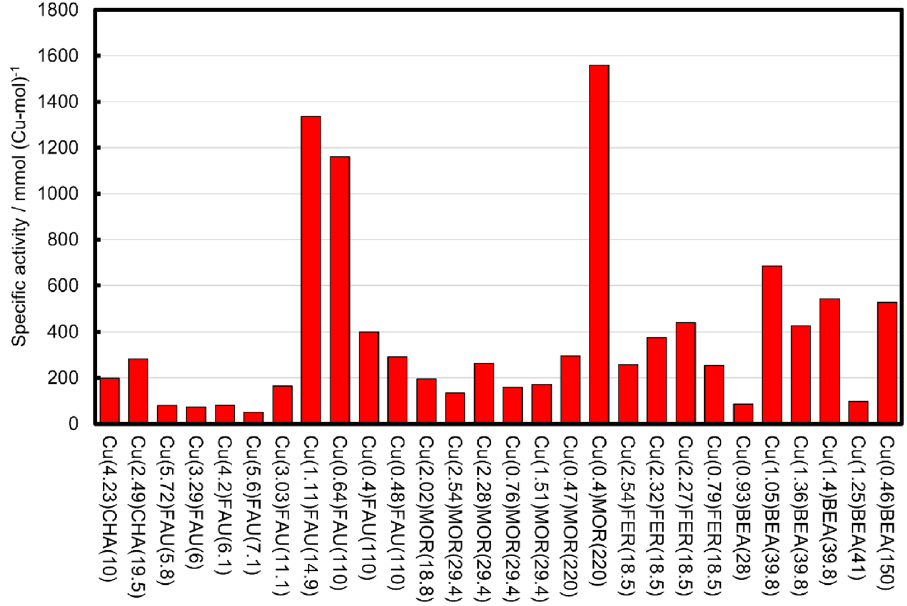
Figure 1. Specific activity of twenty-eight Cu zeolites for the CH 4 –H 2 O 2 reaction. Reaction conditions: CH 4 3.5 MPa, 30 wt% H 2 O 2 155 μL, H 2 O 3 mL, catalyst 10 mg, 60 °C, 1 h. The specific activity is determined by dividing the product increments shown in Fig. S2c with the amount of Cu listed in Table S1.